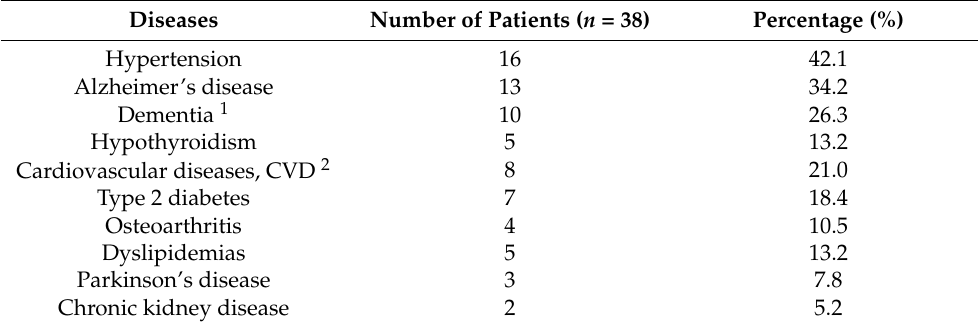
Table 4. Group of diseases diagnosed among study participants.